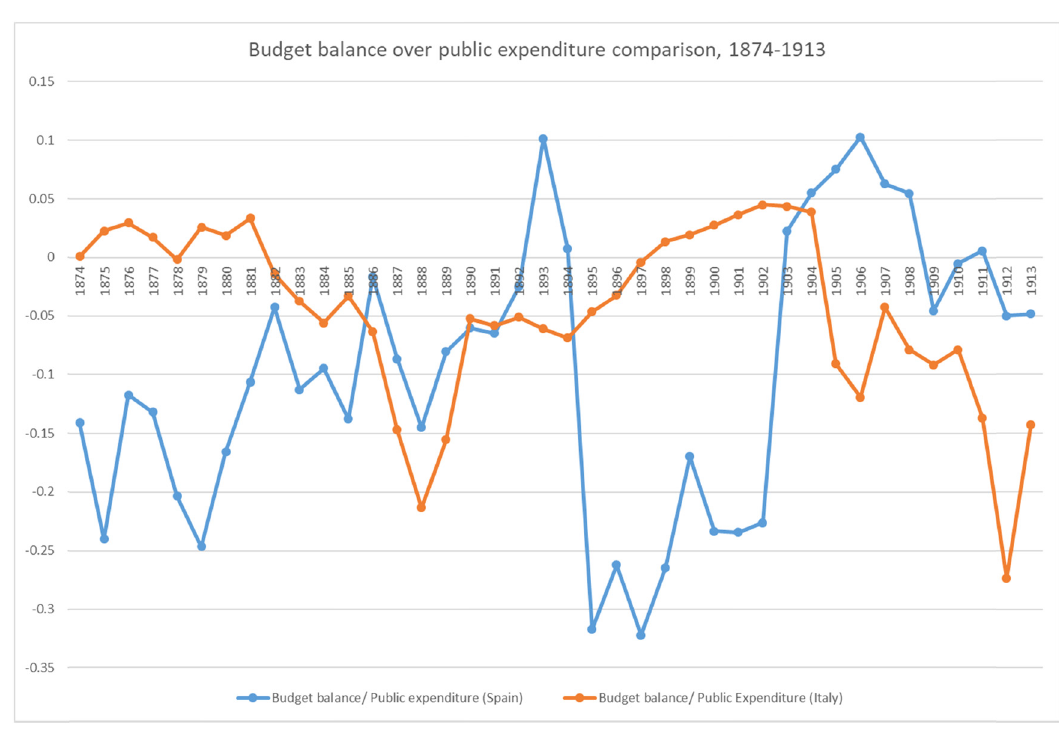
Figure 9: Spanish and Italian fi scal balance over public expenditure. Source: Comin ( 2017 ) and Frattiani and Spinelli ( 2012 ) .